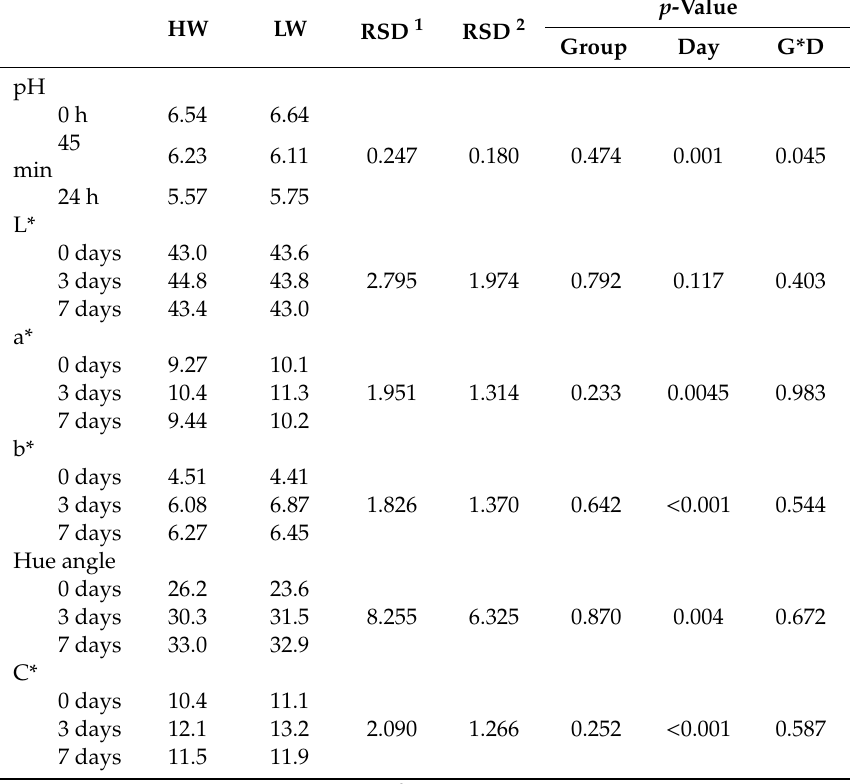
Table5. CarcasspHatdi ff erenttimesafterslaughterandcolorparametersofmeatsamples(M.